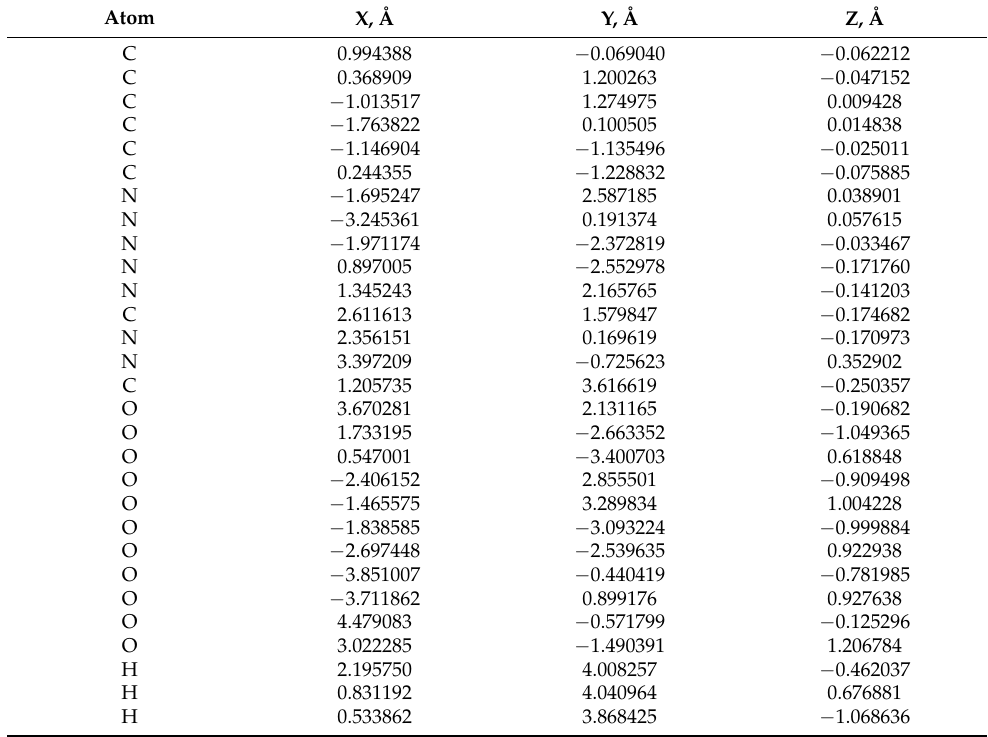
Table A7. Convergent geometries of